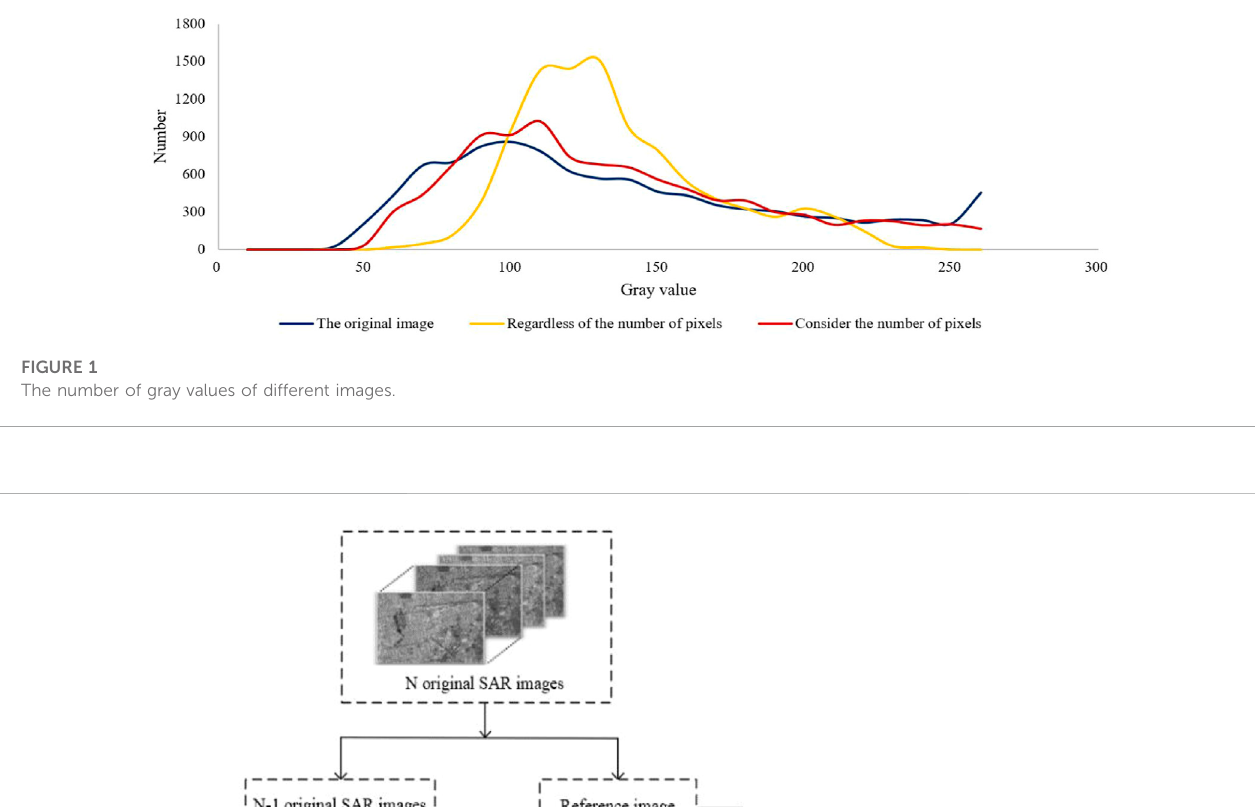
pixels, the fi ltered image has high distortion, and the gray value jumps evidently, which indicates that the aforementioned fi ltering algorithm cannot remove the interference of the speckle well. Thus, the fi ltered image with the number of pixels taken into account is more satis fi ed